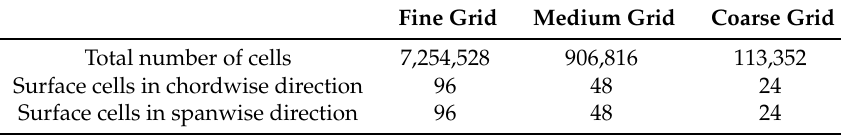
Figure 3. Placement of the cavitator inside the cavitation tunnel. Table 1. Summary of the details of the grid used in the calculations for the three grid levels. The number of surface cells are given for one side of the foil.